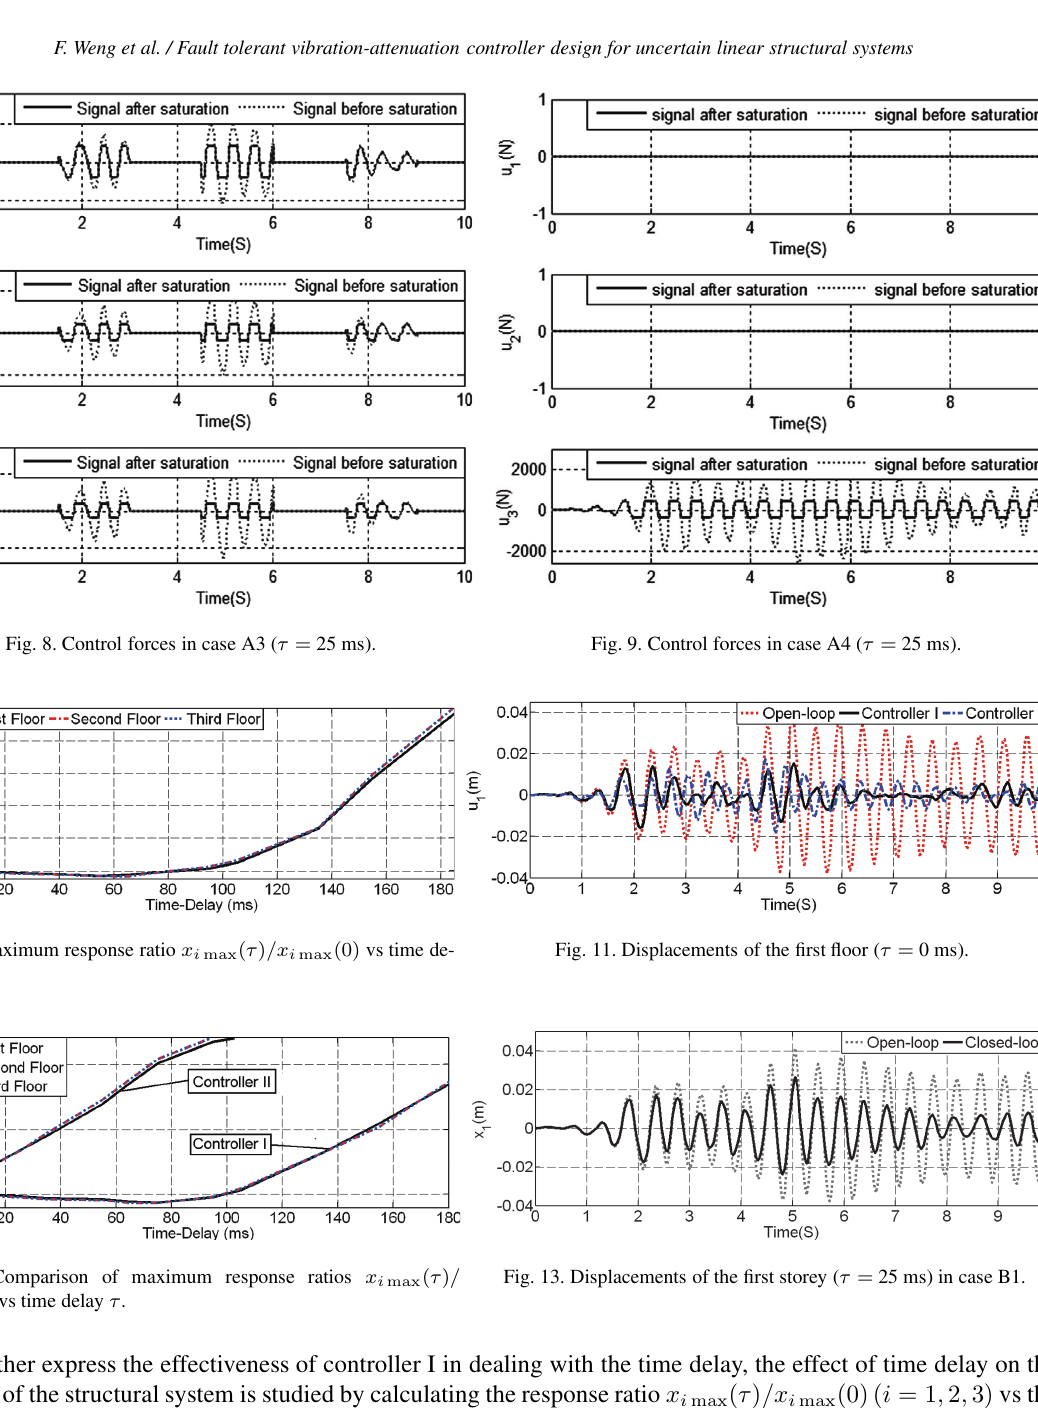
Fig. 13. Displacements of the first storey ( τ = 25 ms) in case